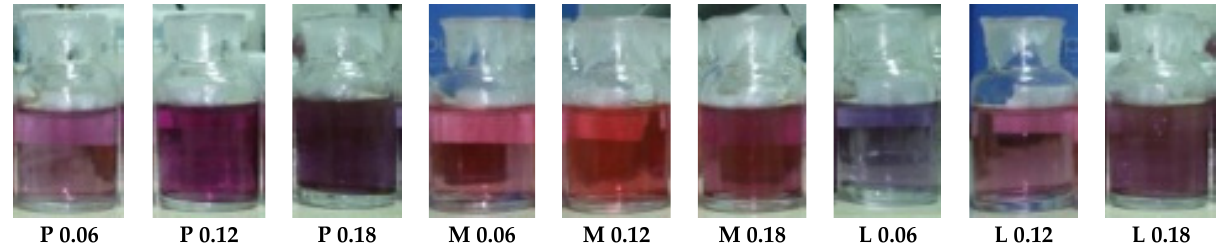
Figure 1. Different shades of AuNPs in solutions that remained stable for a long period of time (12 months).